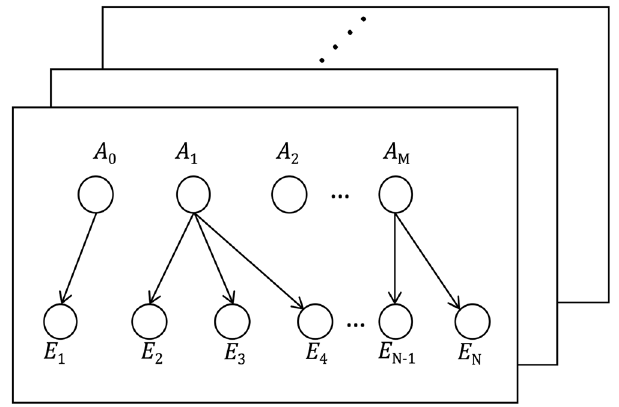
Figure 1. The diagram of the TCI algorithm. Each plate represents a tumour sample. Based on a causal Bayesian network model, TCI infers causal relationships between genes that carry somatic alterations (A) and genes that are differentially expressed (E). A 0 designates all the factors other than gene alterations (e.g., the cellular environment). Each E receives one, and only one, A as its cause, and each A can be the parent of multiple